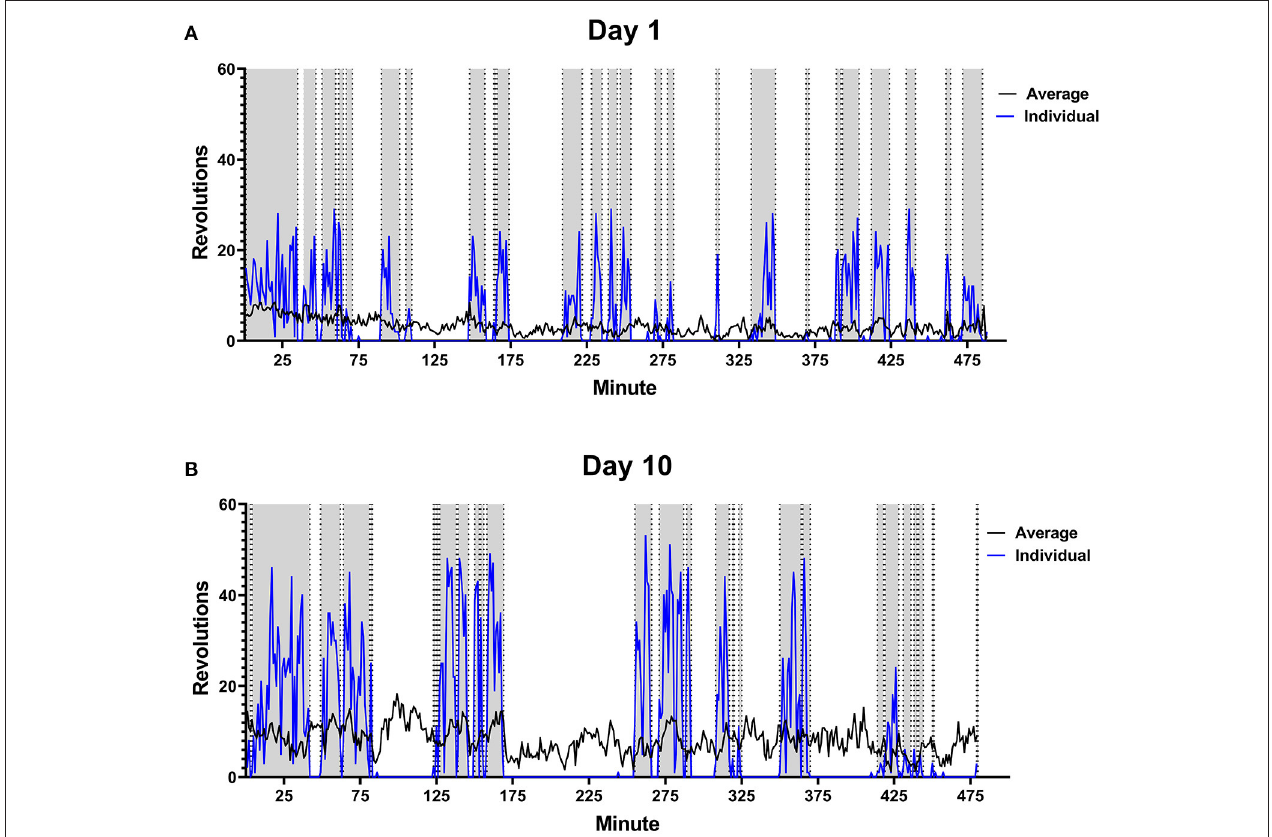
FIGURE 2 | Male Rat Running Pattern. Rats were placed in a cage with voluntary access to a running wheel from 10:00–06:00 (480min) for 10 days. An example is shown of the running pattern of one male in the study on Day 1 (A) and Day 10 (B) of wheel access. Blue line is the number of revolutions run by the individual rat. The gray portions highlight running intervals. Black line indicates average distance run by all male rats on each perspective day ( n = 28).